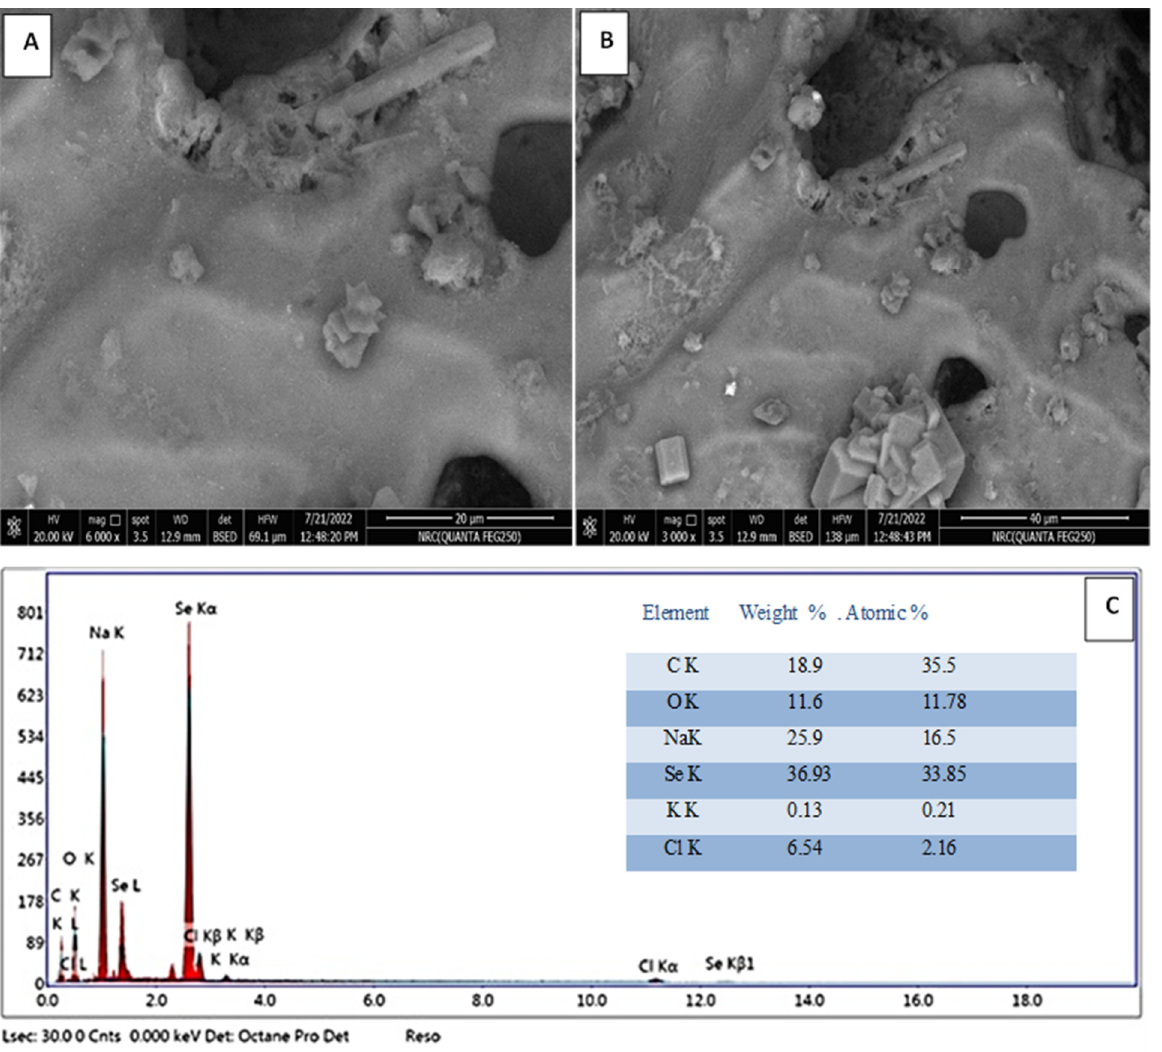
Figure 6. ( A , B ) SEM images of SeNPs in which the nanoparticle was spherical in shape confirmed that SeNPs are in the nano-regime. ( C ) EDX spectrum showed elemental compositions of as-formed SeNPs.